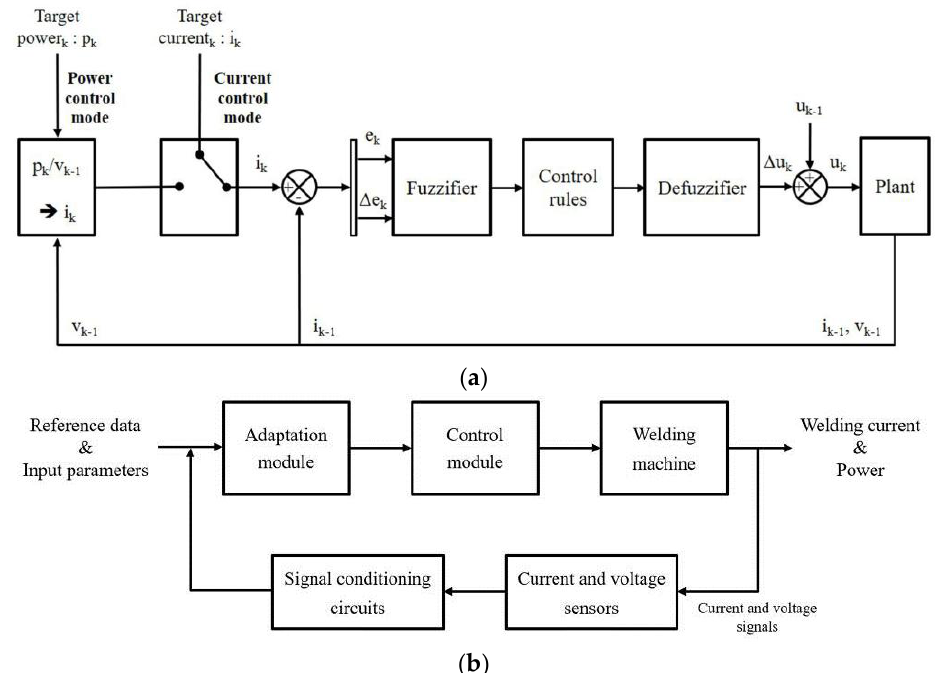
Figure 4. Proposed RSW system components that support the ( a ) welding current and power control and ( b ) adaptive welding process.